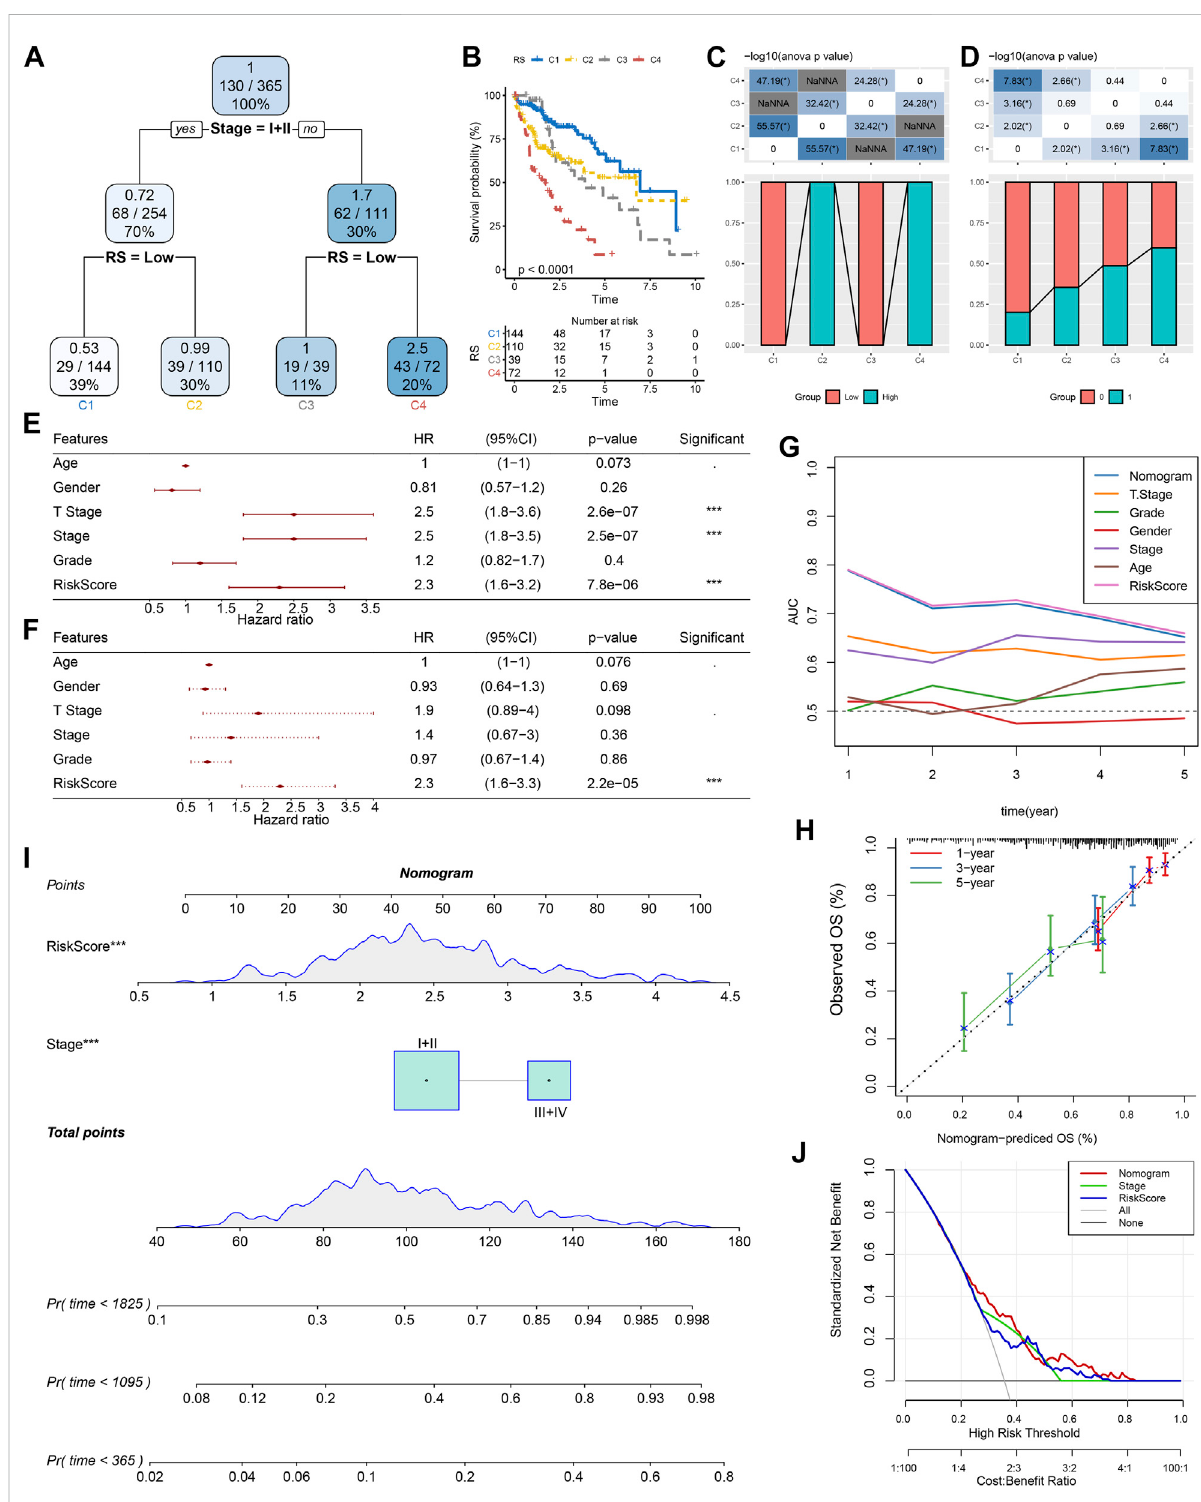
FIGURE 10 Improvement of a prognostic model and survival prediction. (A) The survival decision tree was constructed by using all annotations of patients, including RS, stage, gender, and age, to optimize risk strati fi cation; (B) Overall survival analysis of three risk subgroups; (C – D) : Comparative analysis between different groups; E – F: univariate and multivariate Cox analysis of RS and clinicopathological characteristics; (G) Nomograph model; (H) Calibrationcurveofnomographin1,3and5 years; (I) ROC curvesofdifferentclinicopathologicalcharacteristicsatdifferenttimes; (J) Decision curve of